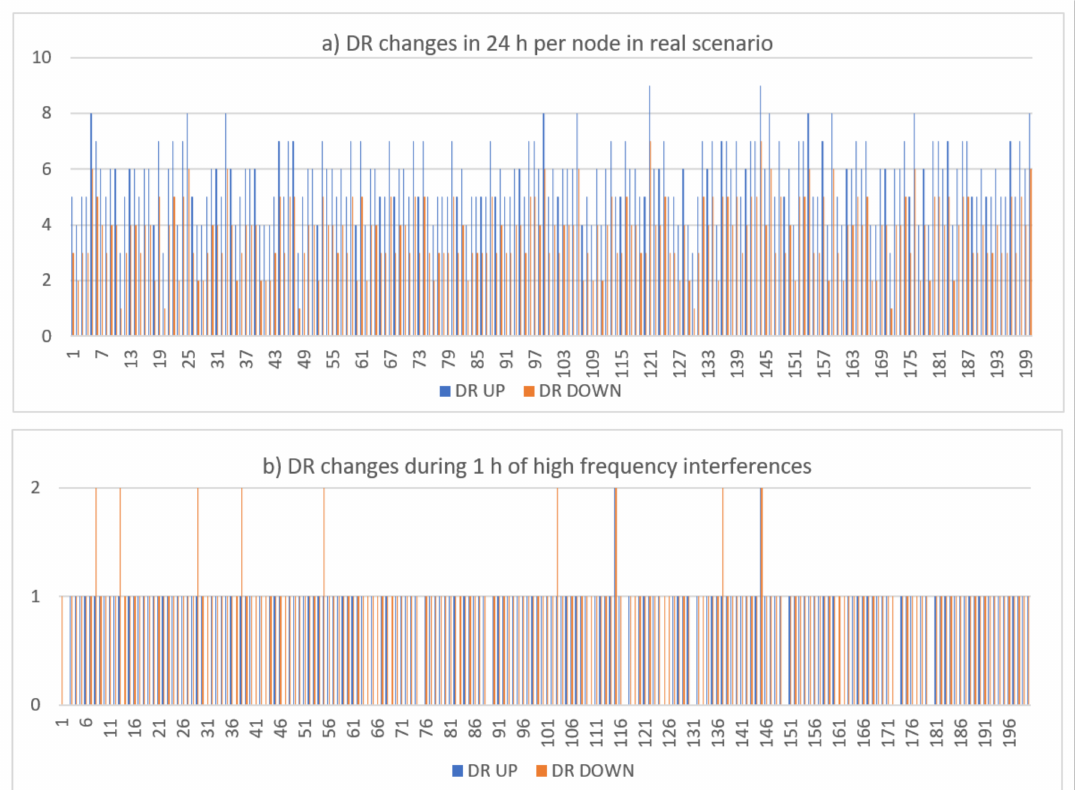
Figure 13. Number of DR changes introduced by the DROB mechanism during 24 h ( a ) and during the 1 h of high frequency interference ( b